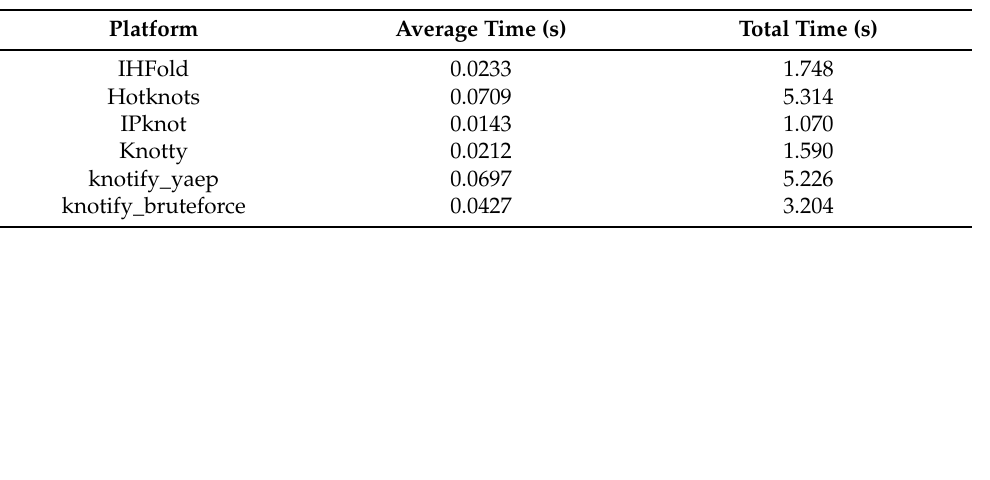
Table 11. Execution time required per platform in for RNA sequences of length <